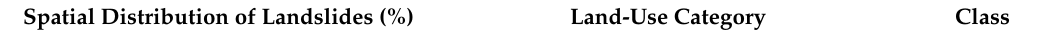
Table 6. Reclassification of the land-use units based on the spatial distribution of landslides (%) in each category, ordered according to increasing